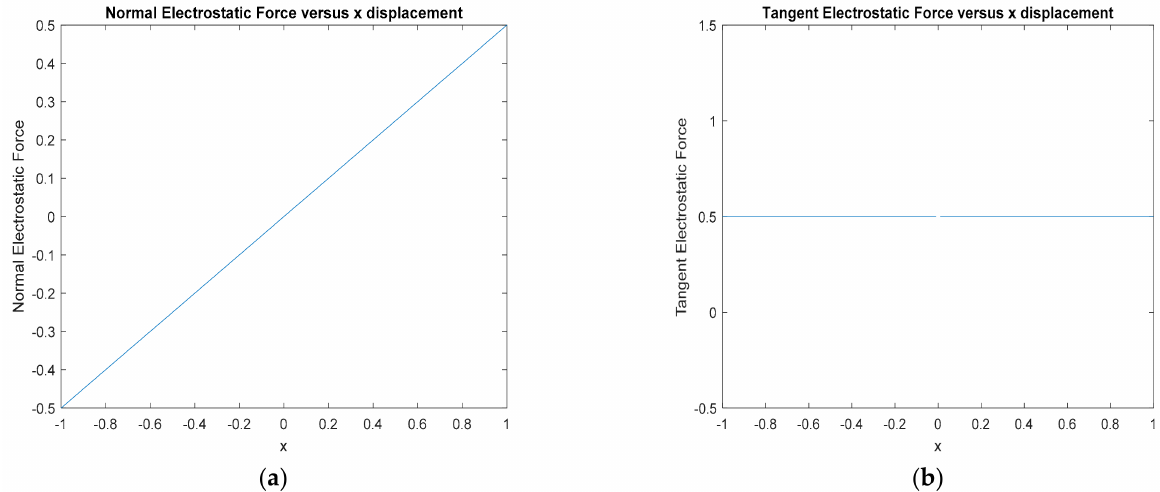
Figure 18. (Above) ( a ) Graph of the Electrostatic normal force with respect to changes in electrode crossover. ( b ) Graph of the Electrostatic tangent force with respect to changes in electrode crossover